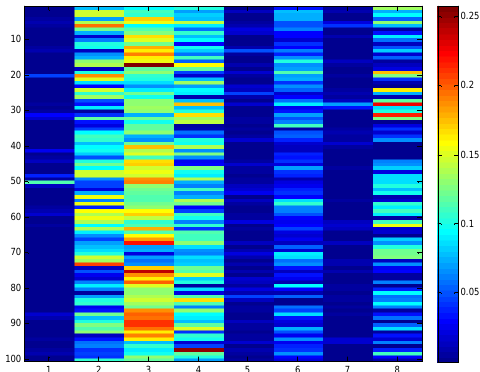
Figure 3. Variance of parameter correlation using 9 windows for